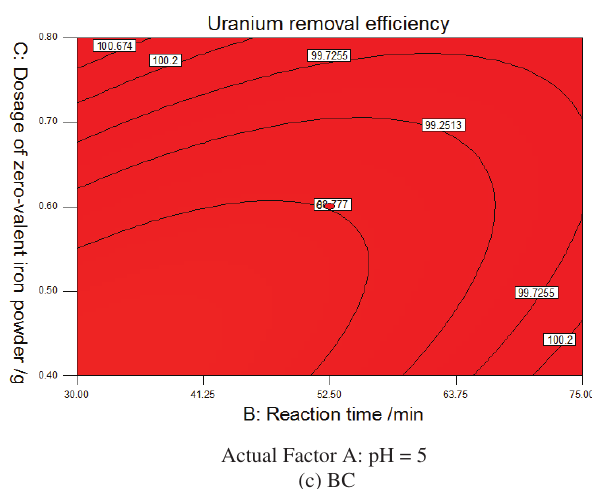
Figure 2: The response surface diagram of the impact of pH, reaction time and dosage of zero-valent iron on uranium removal